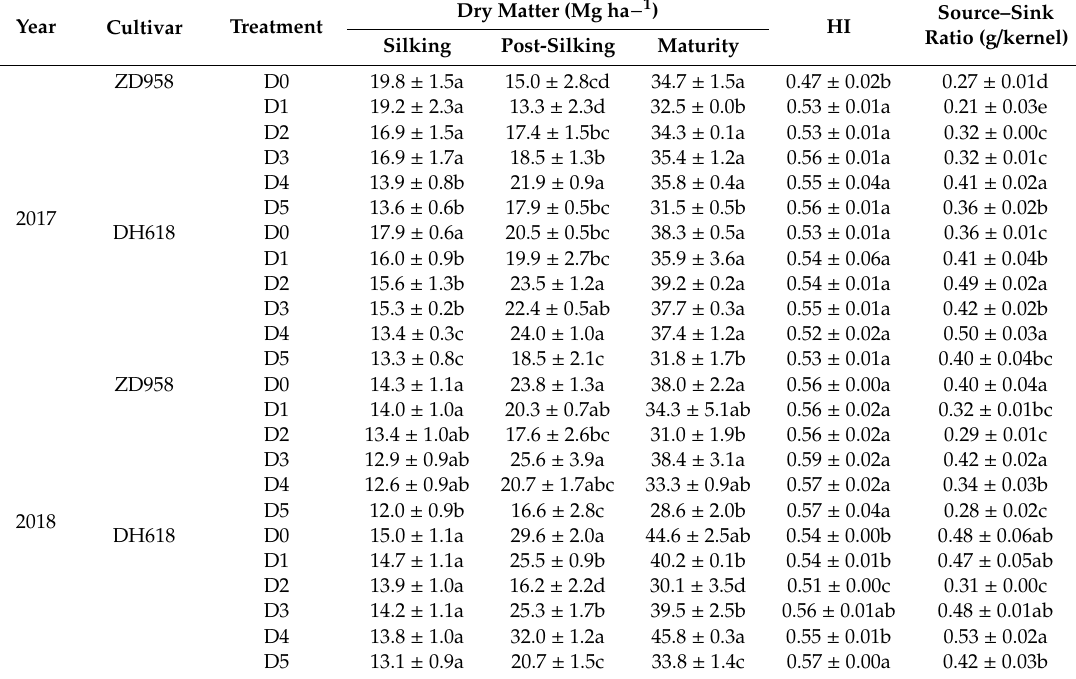
Table 2. Dry-matter accumulation at three di ff erent development stages, harvest index (HI) and post-silking source–sink ratio of maize cultivars ZD958 and DH618 in di ff erent treatments in 2017 and